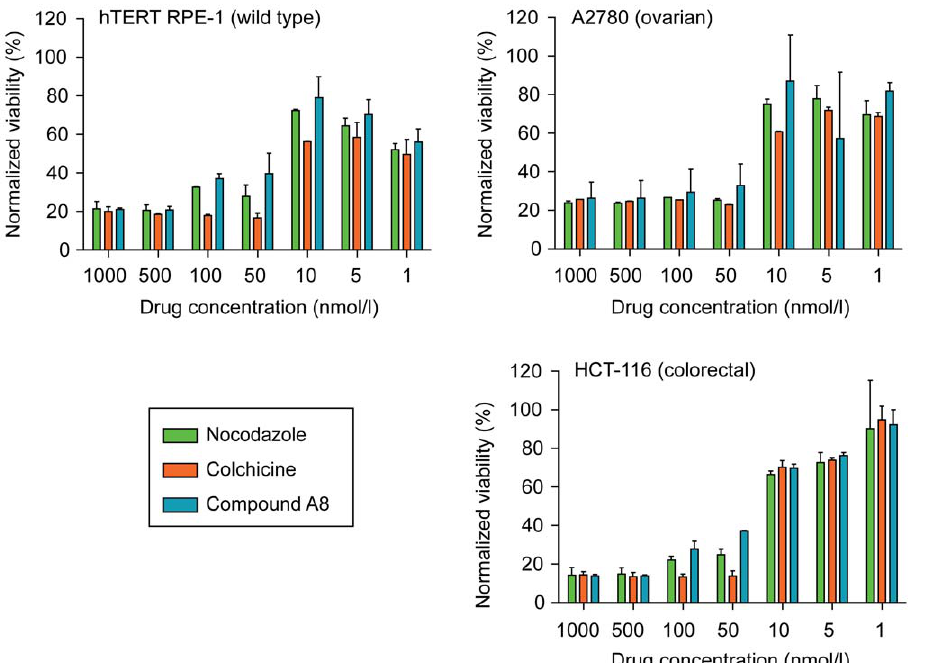
Figure 8. Furan-metoticas kill proliferating cells with an efficiency equaling that of established antitubulin drugs. Viability analysis of hTERT RPE-1 control cells and two adenocarcinoma cell lines following treatment with compound A8 (1–1000 nmol/l); nocodazole and colchicine acted as positive controls.